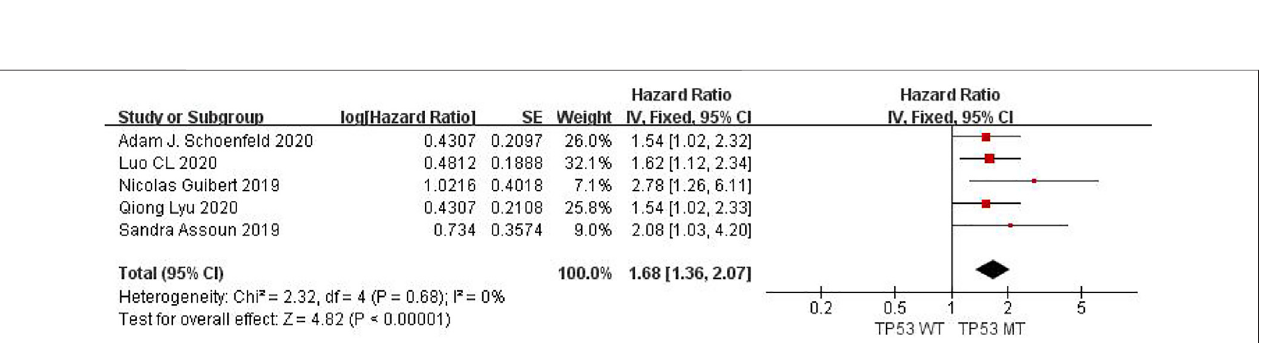
Frontiers in Pharmacology |